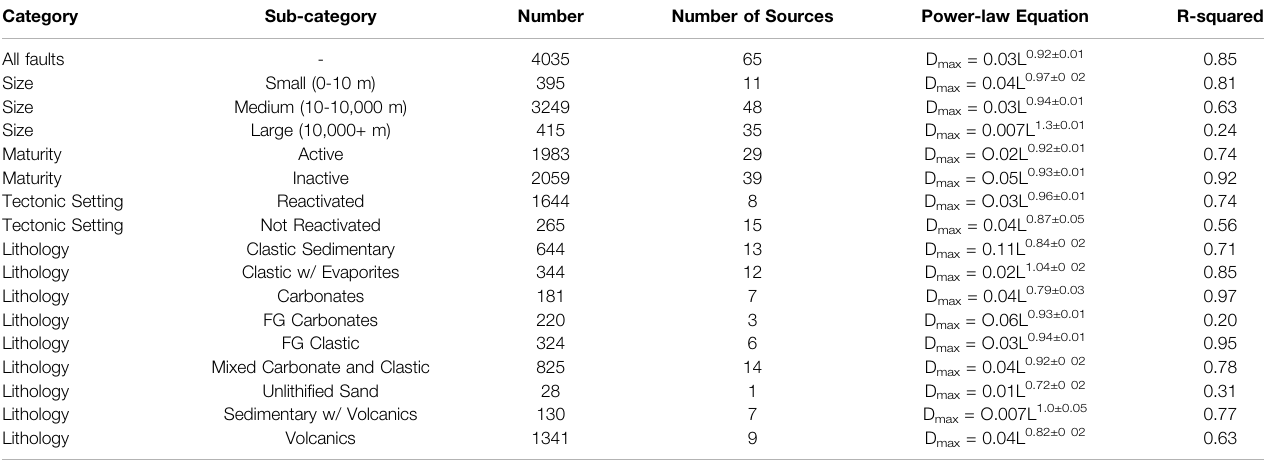
TABLE 1 | Table listing of all the results for each of the studied categories, including number of faults, number of sources, power-law equation that can be used to estimate fault length or displacement, and the R-squared for that